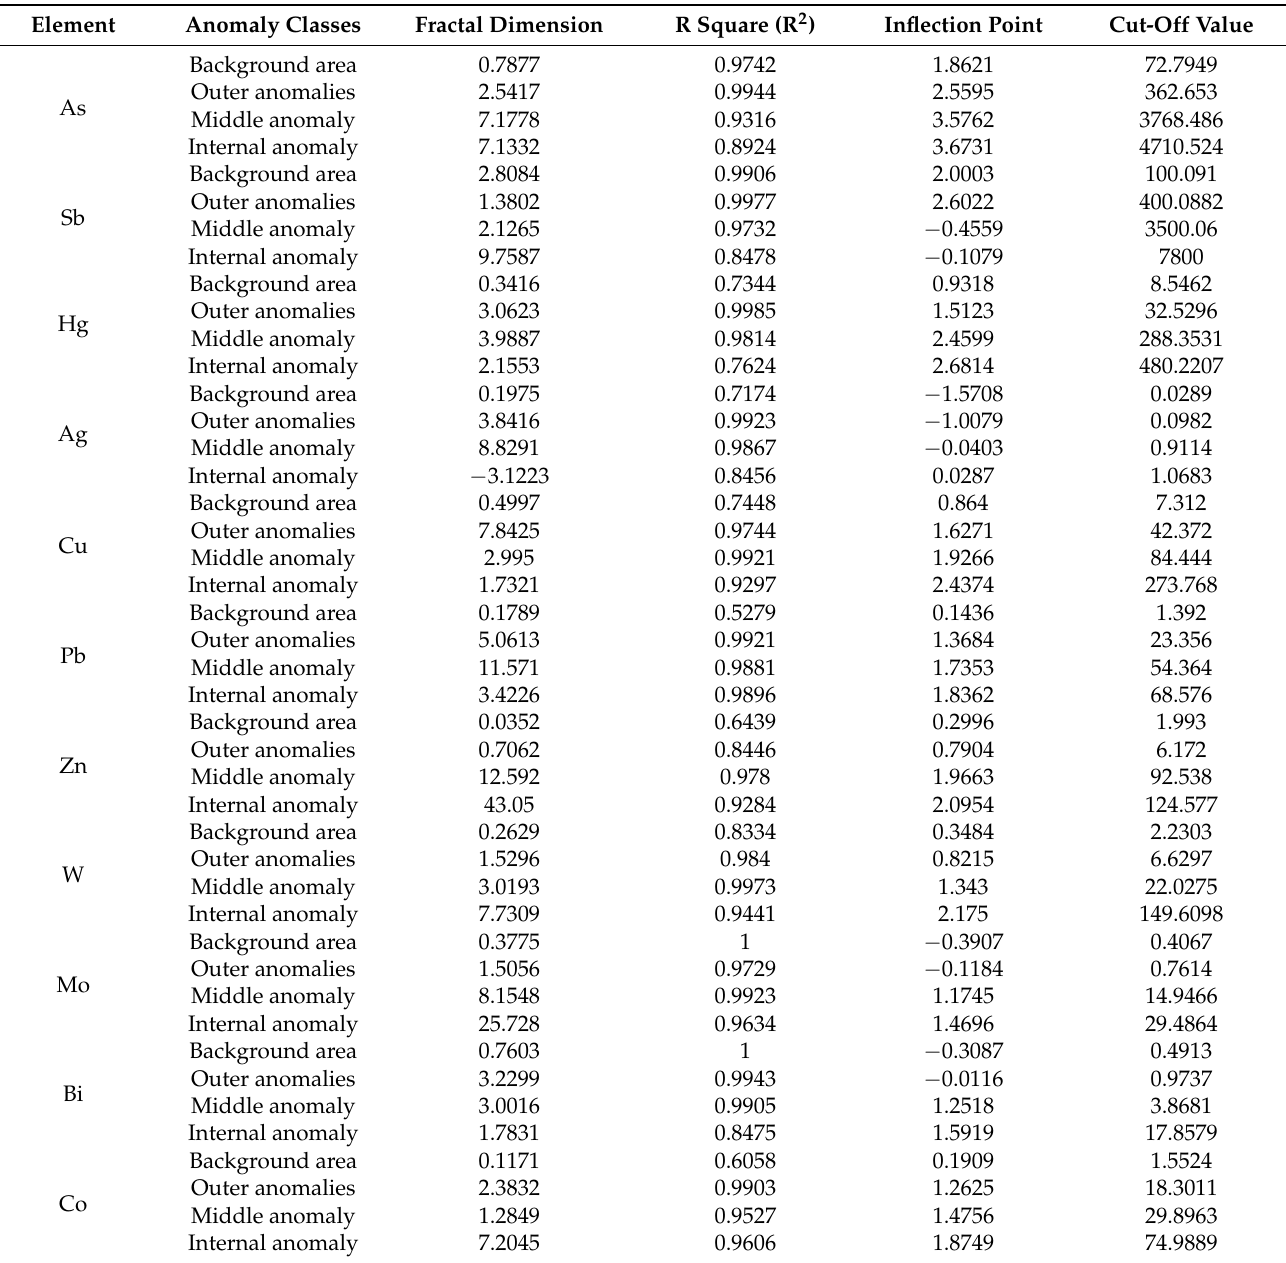
Table 2. Fractal characteristics of remaining elements in 3D data volume